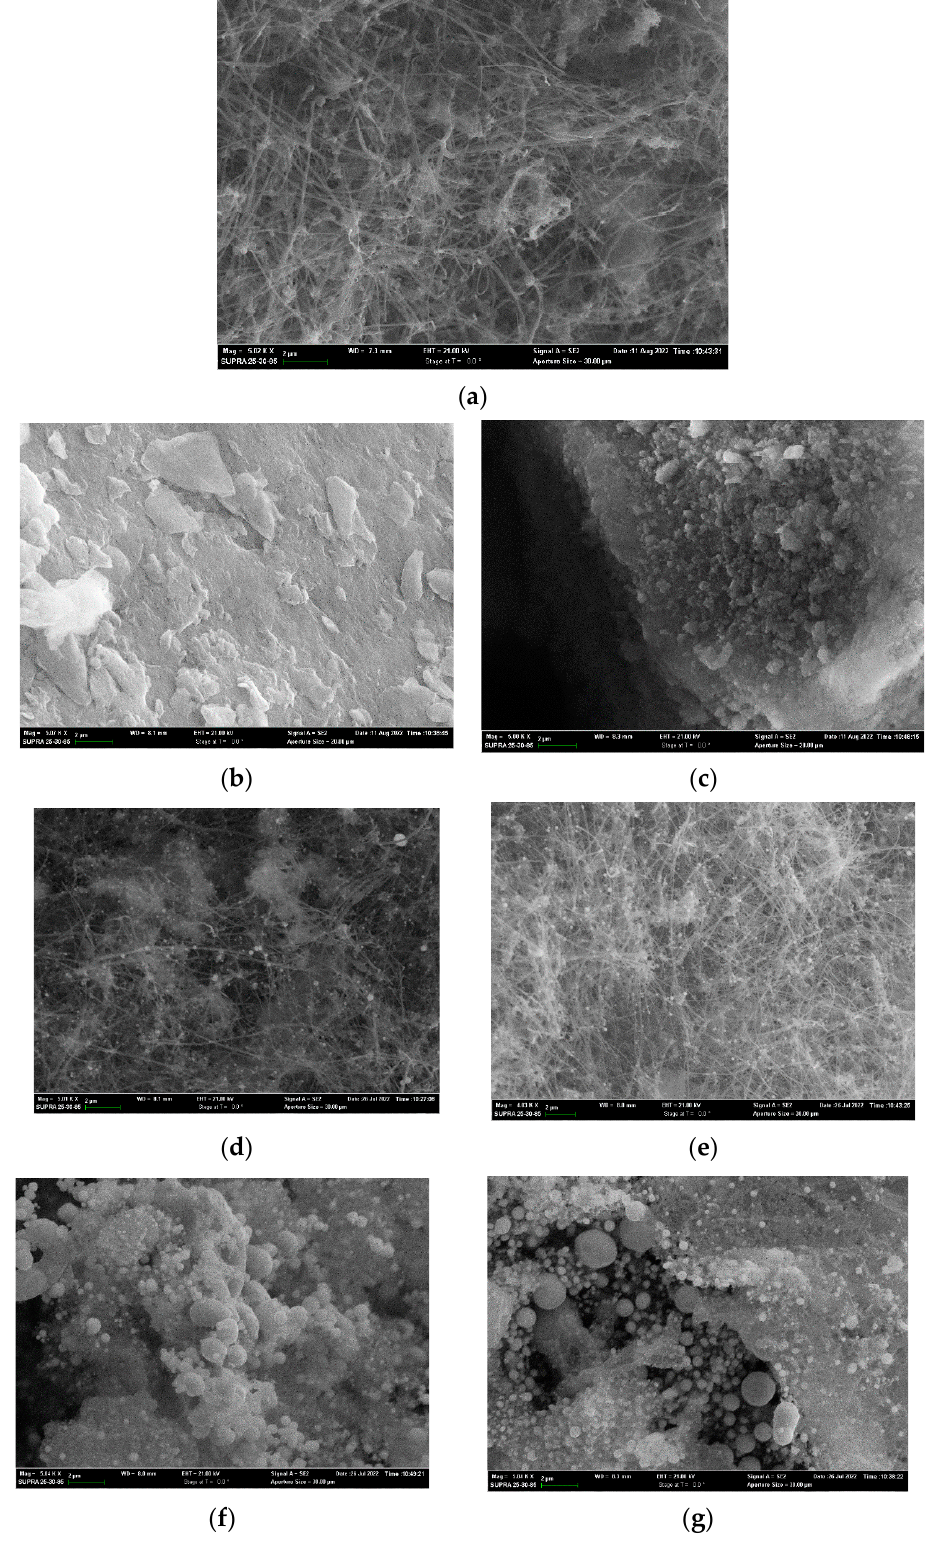
Figure 3. SEM photographs: ( a ) MWCNT (magnification 5000 times); ( b ) GO; ( c ) UDD; ( d ) MWCNT_CoPc_Pd (magnification 5000 times); ( e ) MWCNT_CuPc_Pd (magnification 4000 times); ( f ) UDD_C о Pc_Pd (magnification 5000 times); ( g ) GO_C о Pc_Pd (magnification 5000 times). MWCNT-based catalysts have the structure of intertwining nanotubes on which metal particles are localized. It can be seen that the metal particles have a spherical structure and are regularly distributed in the bulk of the nanotubes; the average size of most particles does not exceed 100–150 nm. Catalysts based on UDD and GO have an amorphous structure in the form of irregularly shaped conglomerates. Metals on UDD and GO form sufficiently large particles and are unevenly distributed over the carrier surface. For the qualitative identification and quantitative determination of metals, X-ray fluorescence analysis and thermogravimetric analysis were used, respectively. Figures 4 and 5 show the corresponding diagrams for some samples of the synthesized catalysts. Figure 4. XRF spectrum of the studied samples. Figure 5. TGA—spectrum for some synthesized samples of catalysts.